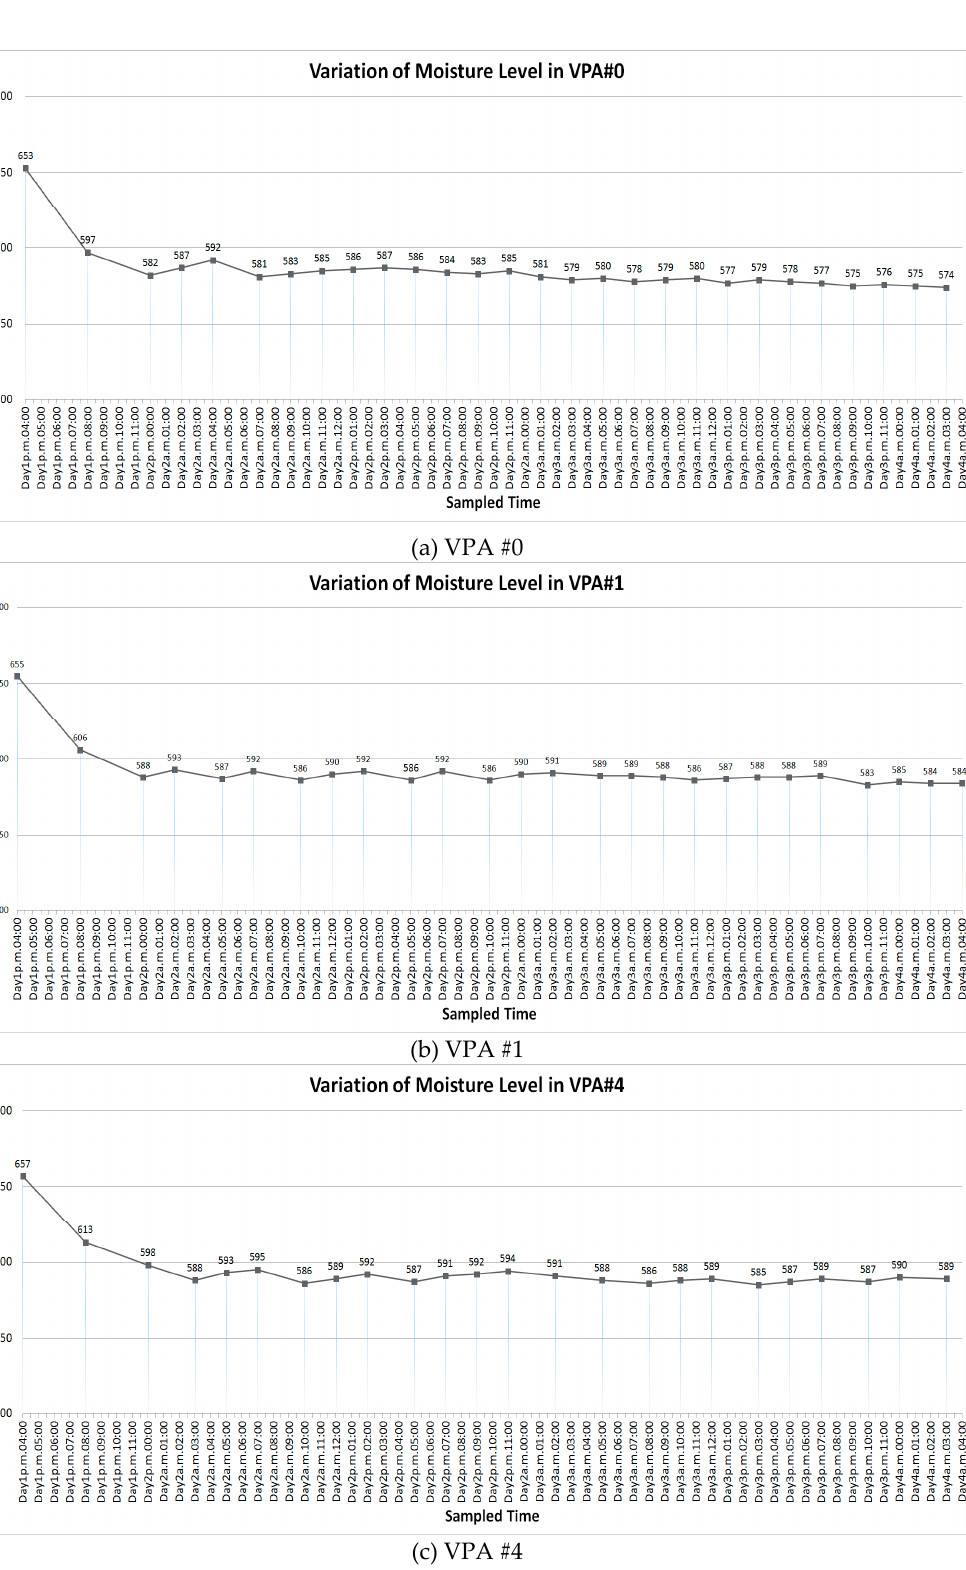
Figure 11. The moisture levels of the sensors at the 3 cm depth layer in different VPA with high air temperature (30 °C–34 °C). The moisture level is ranged from 0 to 1023. ( a ) the moisture level of the VPA#0. This VPA is located at the corner of the experimental plot. Similar VPAs are VPA#2, VPA#6, and VPA#8. ( b ) the moisture level of the VPA#1. Similar VPAs are VPA#3, VPA#5, and VPA#7. ( c ) the moisture level of the VPA#4, which is at the center location of the experimental plot.